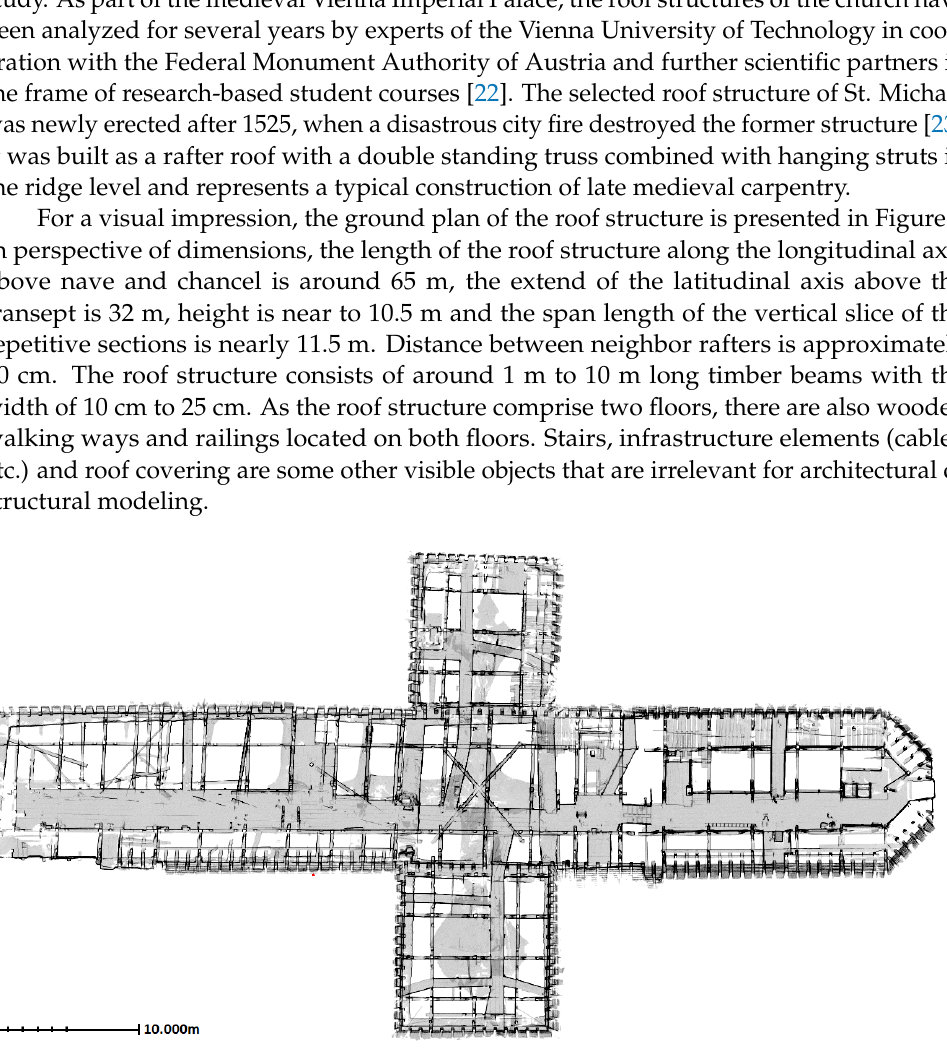
Figure 1. The ground plan obtained from point cloud of the roof structure of St.